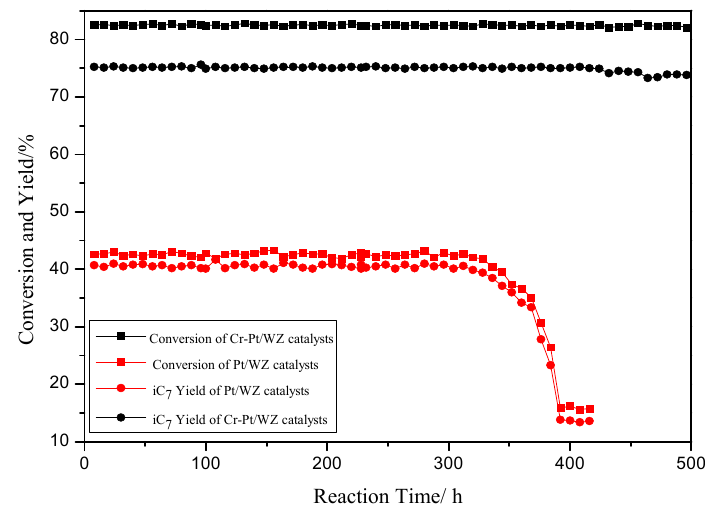
Figure 11. Study on stability of Cr-Pt/WZ catalyst.